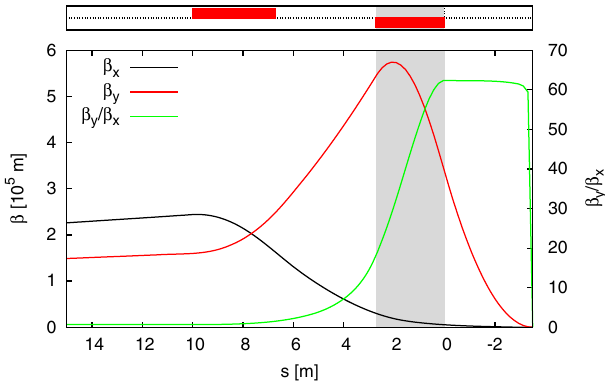
FIG. 8. β functions and β y = β x ratio for CLIC 3 TeV FD, QF1, and QD0 in red on top. The dark area is occupied by QD0, and the IP is at s ¼ − 3 . 5 m.